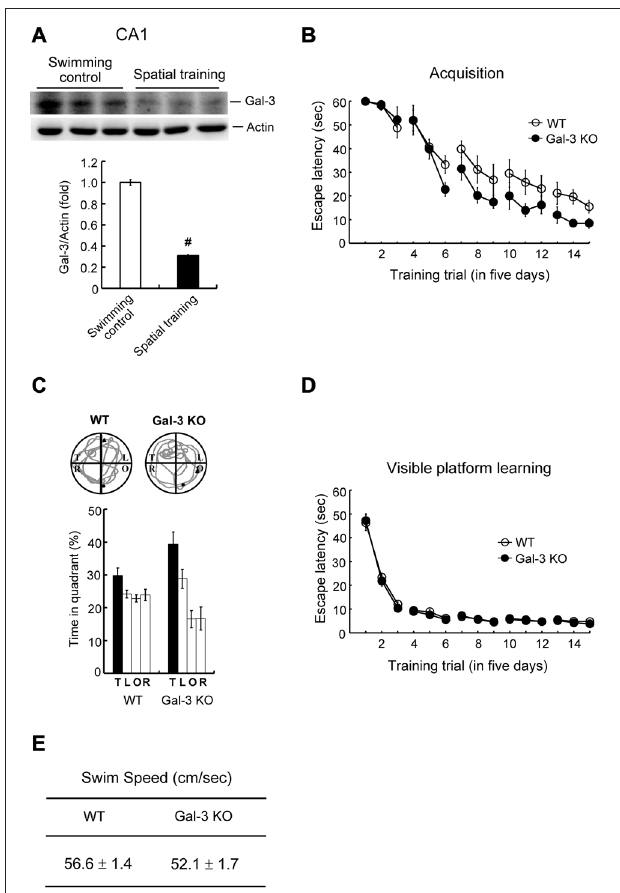
FIGURE 4 | Water-maze training decreases galectin-3 expression in the rat hippocampus and spatial memory is enhanced in galectin-3 KO mice. (A) Western blot showing galectin-3 expression in CA1 area of rats subjected to water-maze training or swimming control. The quantified result is also shown ( t ( 1,10 ) = 23.75, P < 0.001). N = 6 each group. (B) Spatial acquisition of WT and galectin-3 KO mice ( F ( 1,14 ) = 5.34, q = 3.33, P < 0.05). (C) Representative swim pattern and probe trial performance of WT and galectin-3 KO mice (Chi square followed by t -test, t ( 1,14 ) = 1.61, P > 0.05). N = 8 each group. (D) Visible platform learning of WT and galectin-3 KO mice ( F ( 1,14 ) = 0.56, P > 0.05). (E) The swim speed of WT and galectin-3 KO mice ( t ( 1,14 ) = 2.06, P > 0.05). N = 8 each group. Data are mean ± SEM. # P <